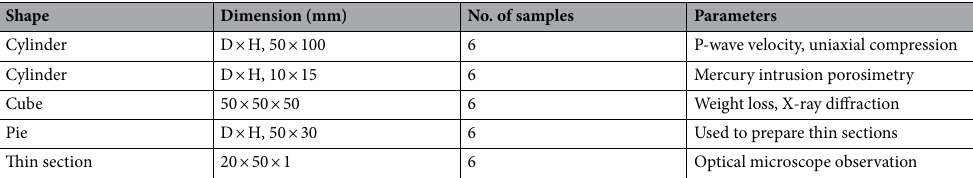
Table 3. Shape and dimension of samples used for different experimental purposes. Note that all samples were prepared from the same marble block. The symbol D and H denotes diameter and height,